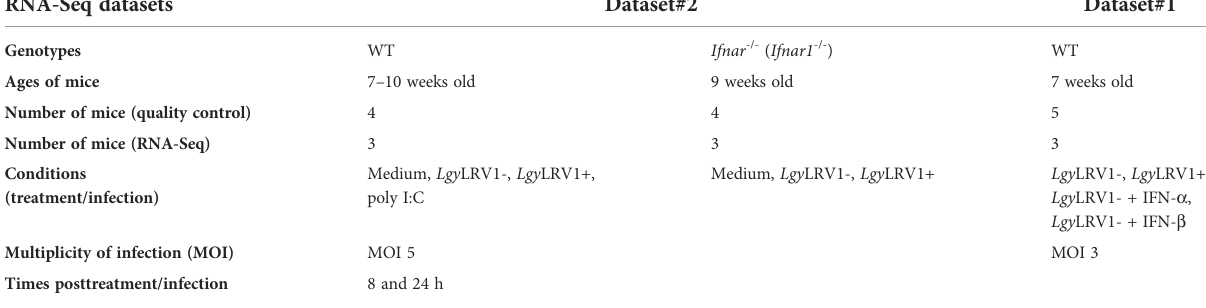
Table explaining the differences and the similarities between the two datasets of samples analyzed in this study. The factors represented are the experimental steps preceding the fi nal sequencingoftheRNA.Twodifferentgenotypes,wildtype(WT)andIfnar -/- ,attwotimepointsp.i.(8and24h)wereused.Bothgenotypesweretreatedwithmedium,LgyLRV1+parasites, LgyLRV1- parasites, or poly I:C. WT was treated in addition to LgyLRV1- parasites + IFN- a , or LgyLRV1- parasites + IFN- b